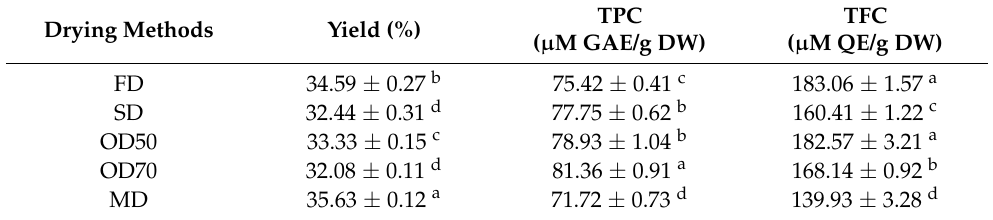
Table 1. Extracting yield, TPC and TFC of extracts from navel orange peel dried by different methods. Drying